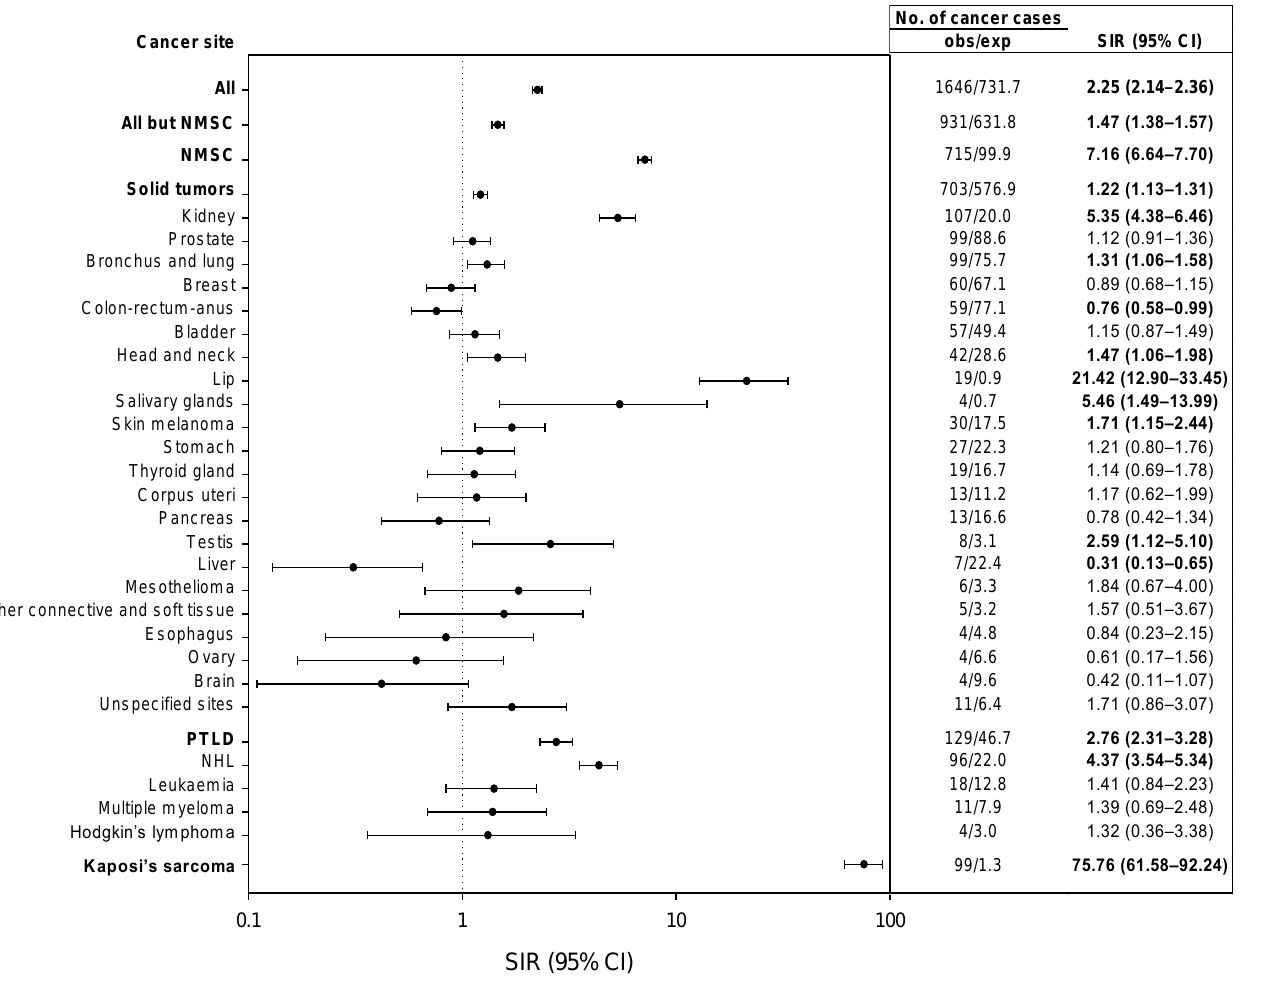
Figure 2. Standardized incidence ratios (SIR) and 95% confidence intervals (CI) for major cancer sites. Sites/types with <4 observed cases are not shown in figure. Abbreviations: NHL, non-Hodgkin lymphoma; NMSC, nonmelanoma skin cancer; obs/exp, observed/expected; PTLD, post-transplant lymphoproliferative diseases. Bold text indicates results that are statistically significant ( p < 0.05). Table 3. Standardized incidence ratios (SIR) and 95% confidence intervals (CI) for major cancer sites by calendar period of cancer